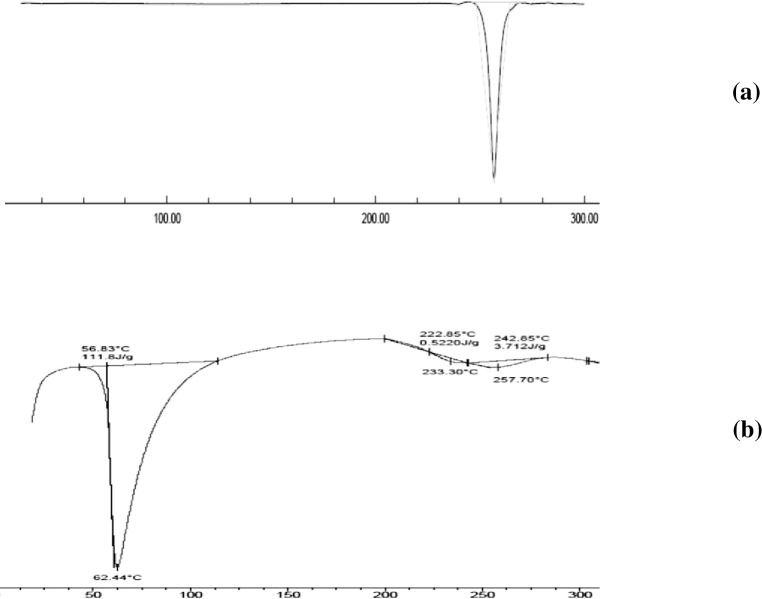
DSC thermograms of drug powder (a) and optimized SD (b).